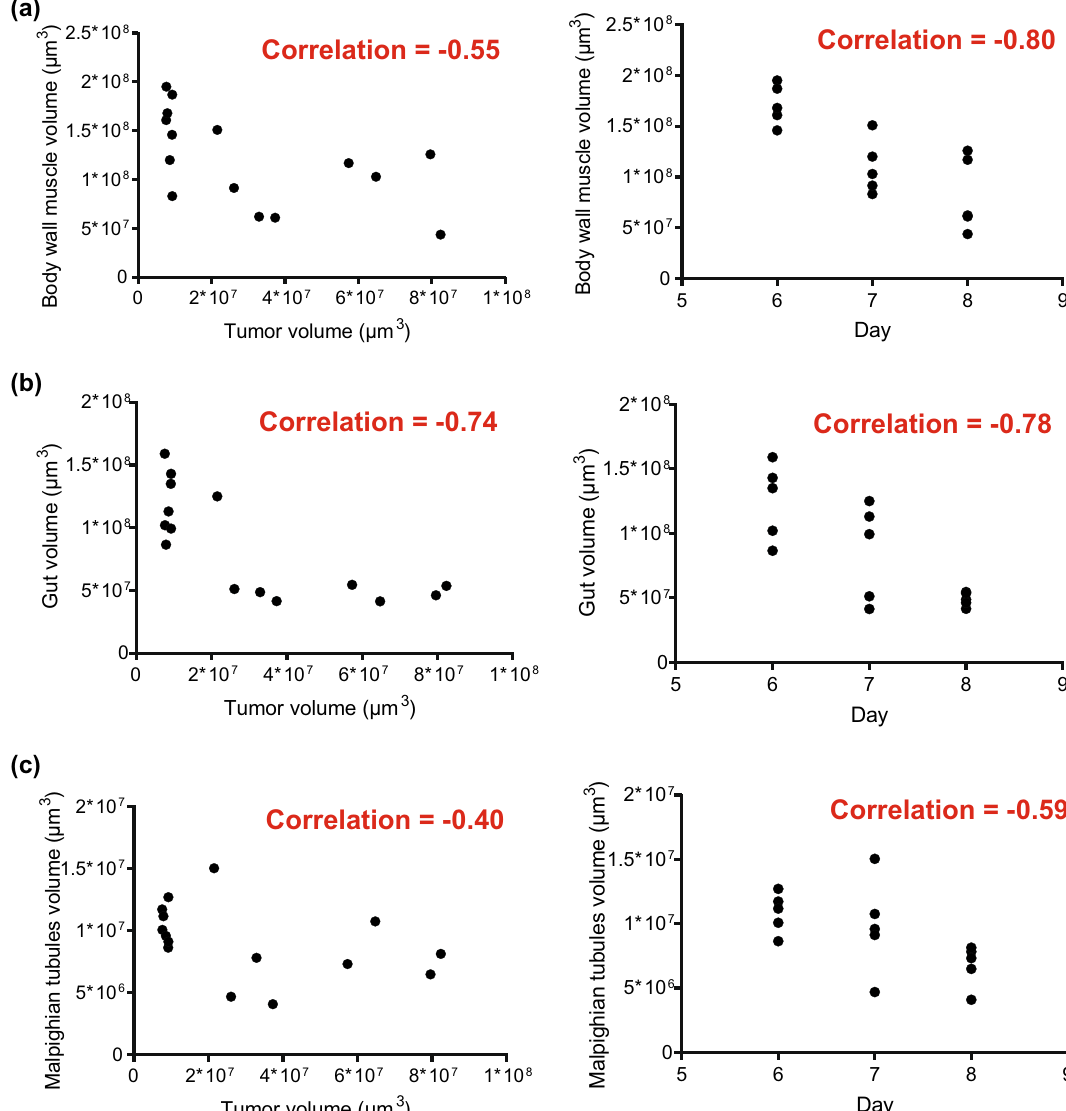
Figure 4. The correlation of organ volume loss is stronger to time with tumor than it is with tumor size. ( a ) Whole-animal body wall muscle volumes compared to tumor volume or time-point. ( b ) Whole gut volume compared to tumor volume or time-point. ( c ) Malpighian tubules volume compared to tumor volume or time- point. For all plots, the red line indicates a linear regression fit of all datapoints. The Pearson correlation of the x- and y-axis values is shown in red in each graph. All panels are of n = 15 larvae in total. In panels where the x-axis shows days, each day has n = 5